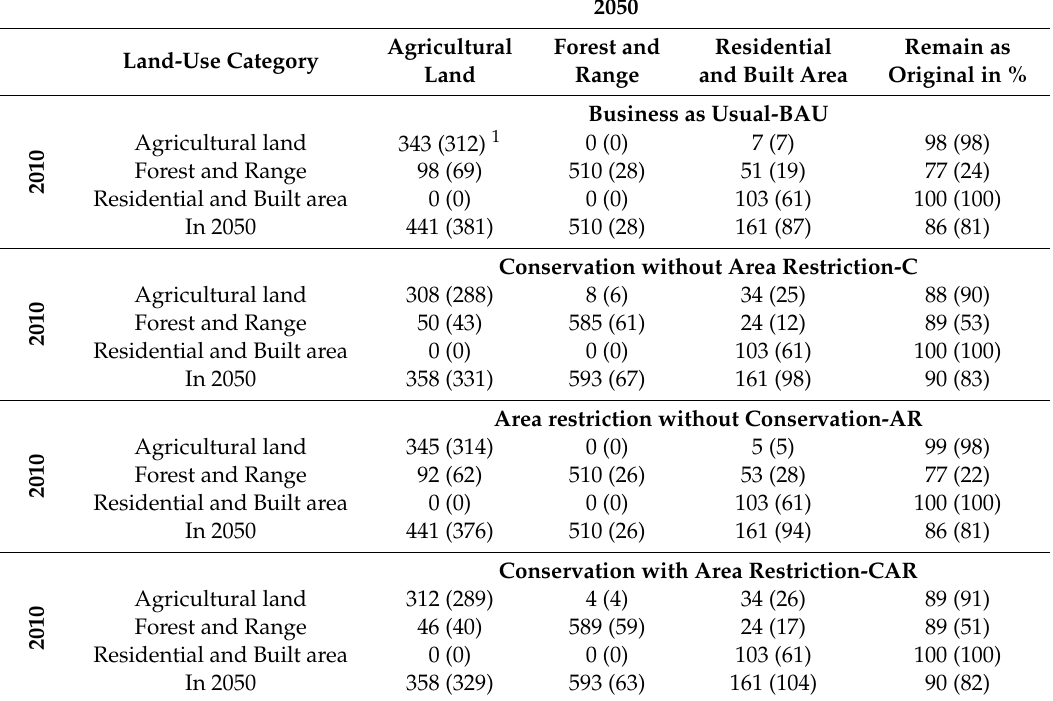
Table 3. Aggregate land-use changes by land-use type for all four scenarios, together with changes specific to land within the agricultural land reserve. The values in parentheses count cells that are in the